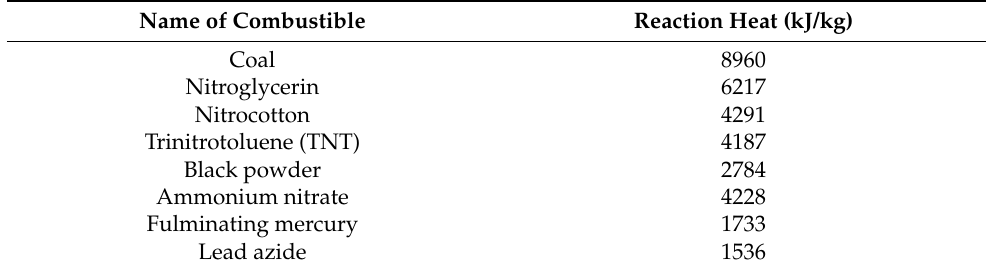
Table 1. Comparison between the reaction heat of coal and some explosive